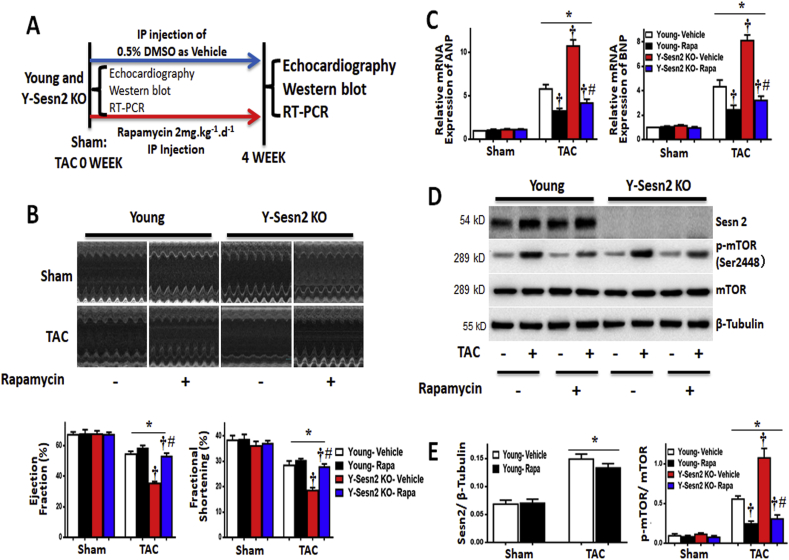
Inhibition of mTOR reduced cardiac hypertrophy induced by pressure overload. (A) Experimental design: Y-Sesn2 KO mice and young WT (Young) littermates were treated with intraperitoneal (IP) rapamycin or dimethylsulfoxide (DMSO, vehicle). Hearts of Y-Sesn2 KO and young WT mice were monitored by ultrasonography, and harvested 4 weeks after transverse aortic constriction (TAC) for immunoblotting and qPCR. (B) Echocardiography showed that rapamycin treatment improved the resistance of Y-Sesn2 KO hearts to TAC, as demonstrated by EF and FS (n = 5–10 per group). (C) Relative expression analysis of ANP and BNP (n = 5–6 per group). (D) Immunoblot for indicated proteins from hearts of sham or TAC operated young WT or Y-Sesn2 KO mice, treated with or without rapamycin. (E) Quantification of Sesn2 protein in sham or TAC operated young WT mice, treated with or without rapamycin, as well as quantification of phospho-mammalian target of rapamycin (p-mTOR)/mTOR expression in sham or TAC operated young WT or Y-Sesn2 KO mice, treated with or without rapamycin (n = 5–6 per group). Values are mean ± SEM, *p < 0.05 vs. Sham group; †p < 0.05 vs. corresponding young WT group; #p < 0.05 vs. corresponding Y-Sesn2 KO group.